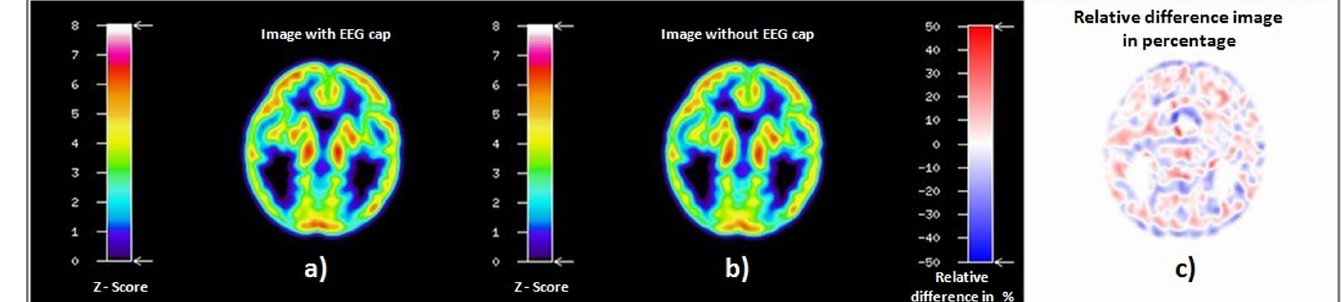
Fig 4. Emission images of the Iida phantom with EEG cap (a), and without EEG cap (b), both reconstructed using the attenuation map without EEG cap; relative difference image in percentage (c).